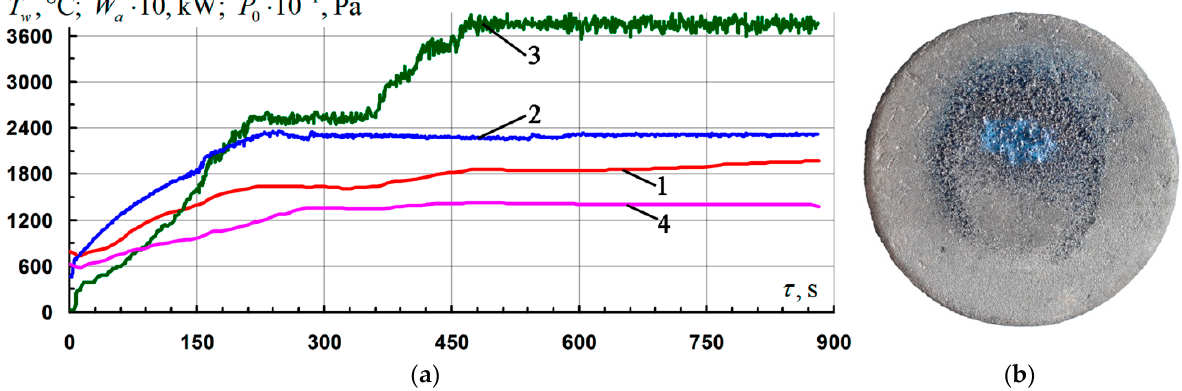
Figure 5. Results of gas-dynamic tests of C f /C–SiC samples coated with the Si–TiSi 2 –MoSi 2 –TiB 2 –CaSi 2 system at T w = 1850–1860 °C: ( a ) change of mode parameters in time: 1, 4—temperature of the front/back surface of the sample at the critical point, T w ; 2—generator power, W a ; 3—braking pressure in the pre-chamber of the heater, P 0 ; ( b ) typical view of the front side of the samples after testing. Table 3. Results of gas-dynamic tests of C f /C–SiC samples with a coating of the Si–TiSi 2 –MoSi 2 –TiB 2 –CaSi 2 system at different